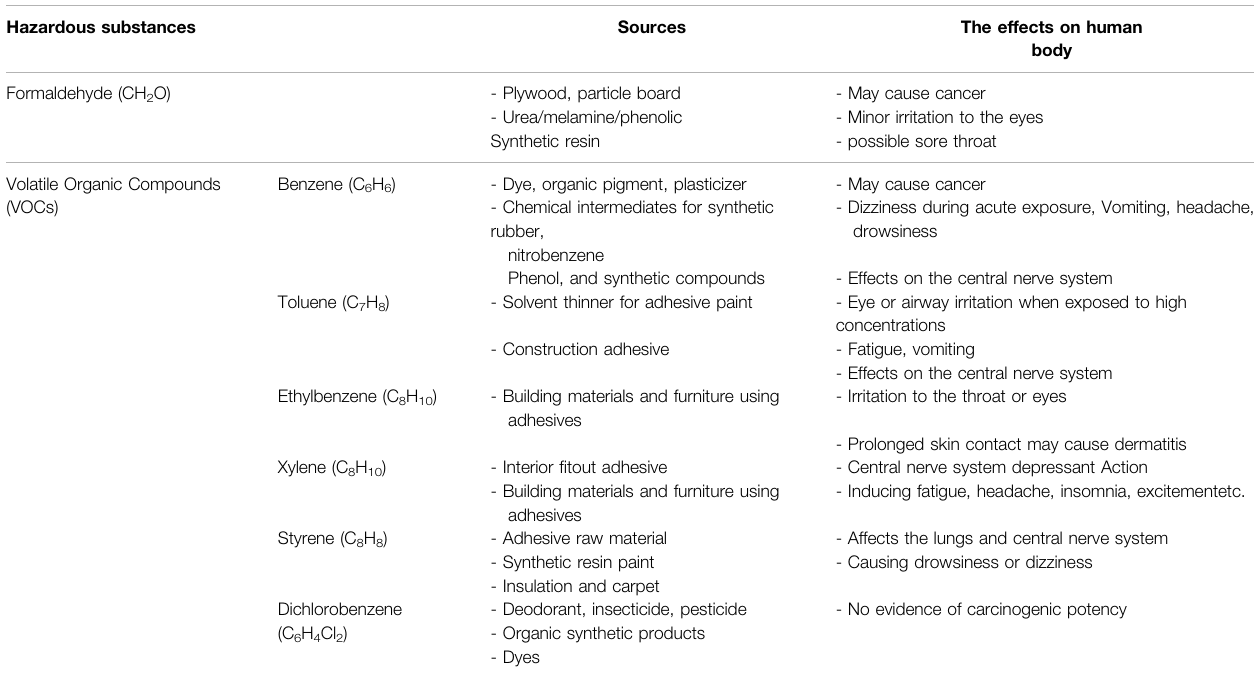
TABLE 2 | The effects of hazardous substances on the human body. Hazardous